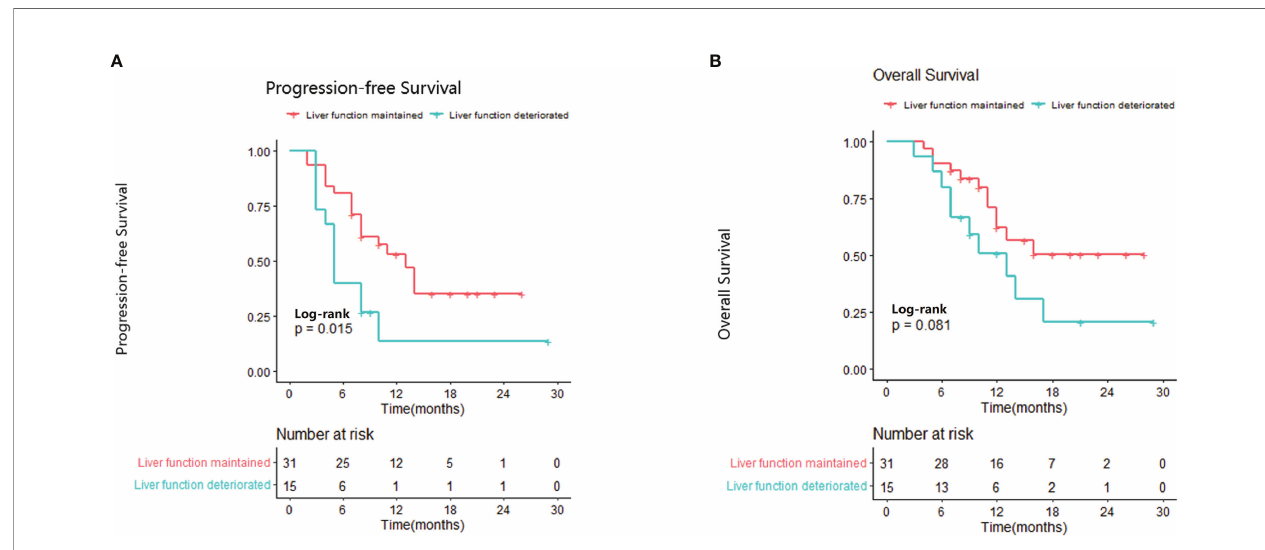
FIGURE 2 | Relationship between liver function and progression-free survival (A) and overall survival (B)